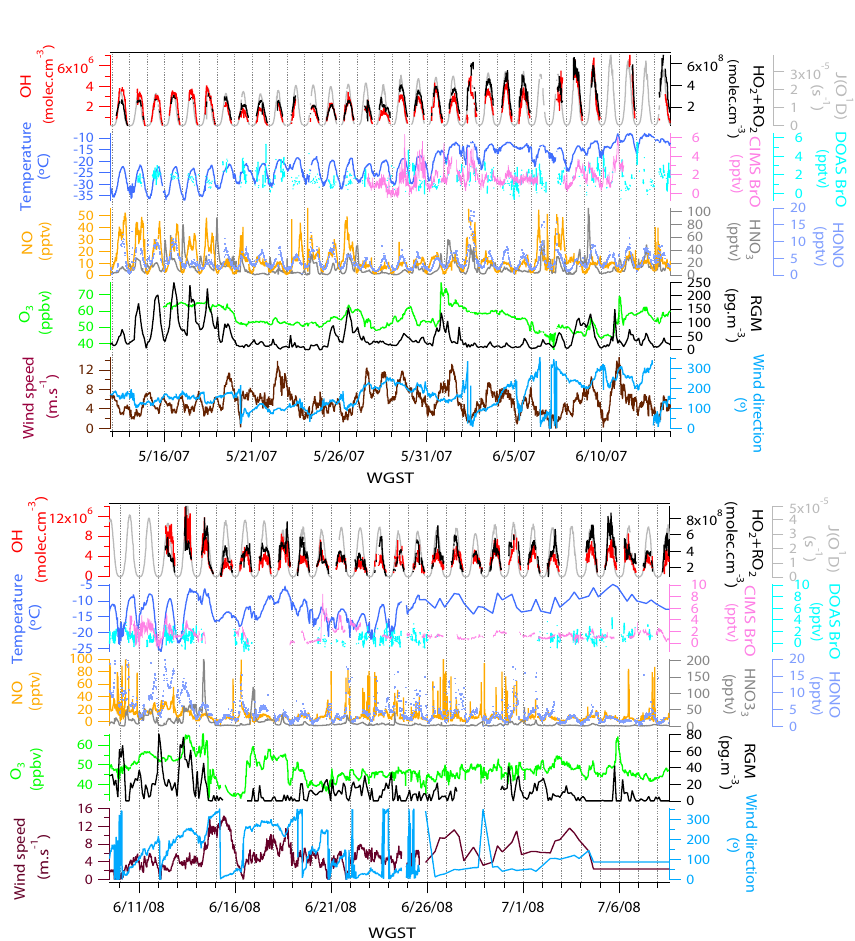
Fig. 2. Time series of measurements of HO 2 +RO 2 , OH, J (O 1 D), BrO, temperature, NO, HNO 3 , HONO, O 3 , RGM, wind speeds and directions on a 10min time base in spring 2007 (top panel) and summer 2008 (bottom panel) Summit